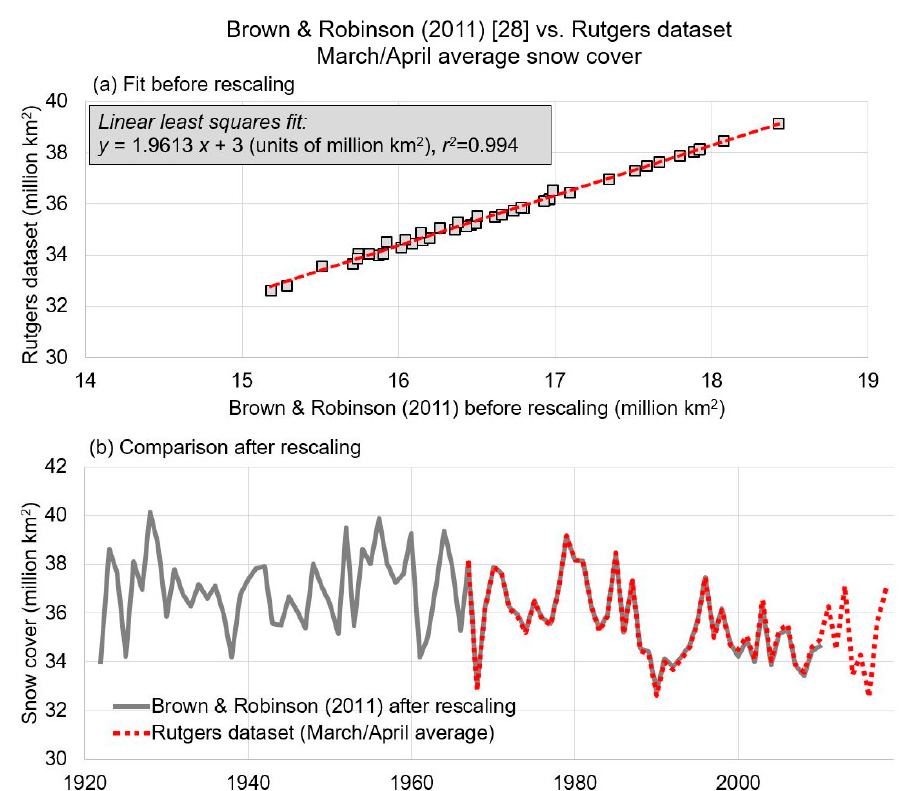
Figure 1. ( a ) Relationship between the Brown and Robinson [28] dataset ( x -axis) and the Rutgers dataset ( y -axis) for the average March/April snow cover over the period of common overlap (1967–2010). ( b ) Comparison of the rescaled version of Brown and Robinson [28] with the Rutgers dataset for average March/April snow cover.